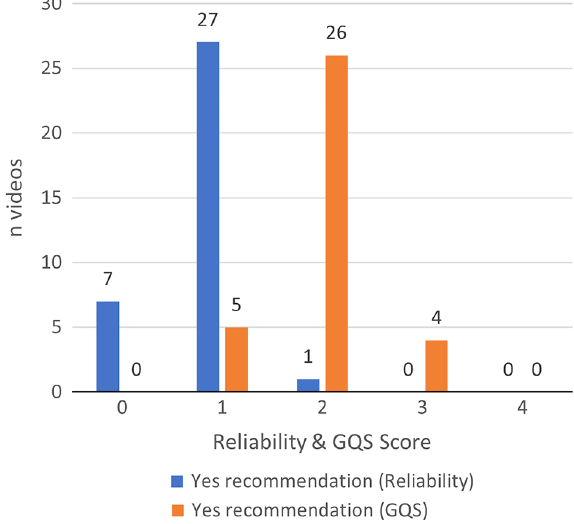
Figure 3. Author vs. average reliability, average GQS and average Log video 10